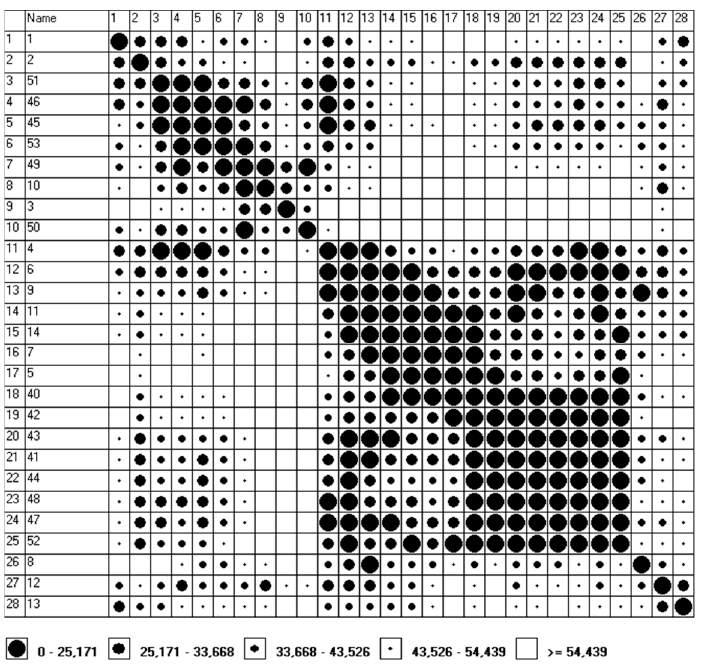
Figure 1. Czekanowski’s diagram—“winter period”. (The MaCzek v. 3.0 program generates the graphic image of the grouping of objects by itself: the first column and the horizontal axis (the row at the top of the drawing) contain the numbers assigned to the following weeks (the second column is the number of the weeks counted from the beginning of the year).)